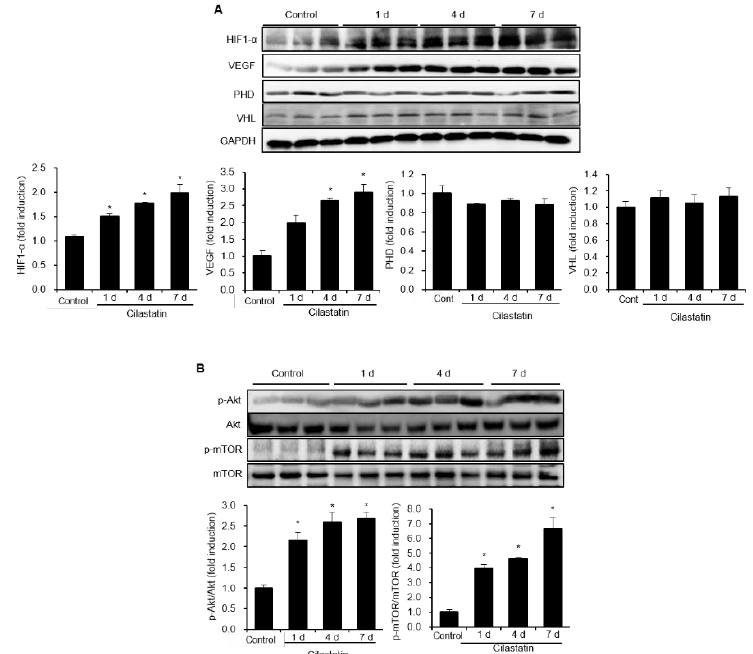
Figure 5. Cilastatin treatment upregulated HIF- 1α expression and its upstream and downstream signaling pathways in mouse kidney. ( A ) Cilastatin treatment enhanced HIF- 1α and VEGF expression in a time-dependent manner in mouse kidney, but it did not affect VHL and PHD expression. ( B ) Cilastatin treatment enhanced Akt and mTOR phosphorylation in a time-dependent manner in mouse kidney. The data are presented as means ± SEM. * p < 0.05.